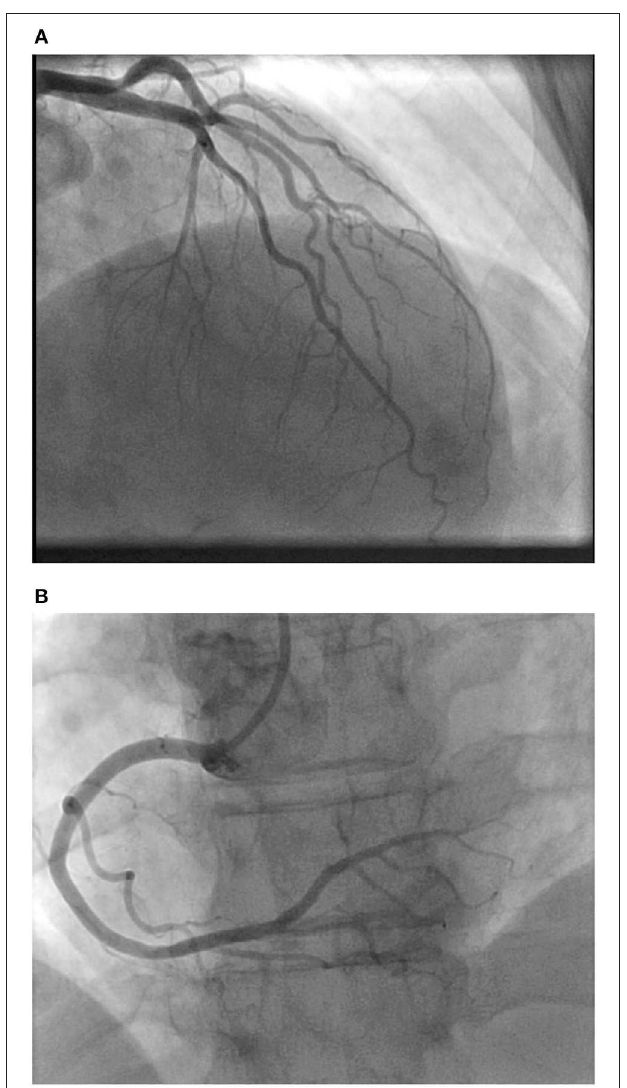
FIGURE 2 | (A) Coronary angiogram showing left coronary artery circulation with a non-occlusive lesion in proximal left circumflex artery. (B) Coronary angiogram showing right coronary artery circulation.